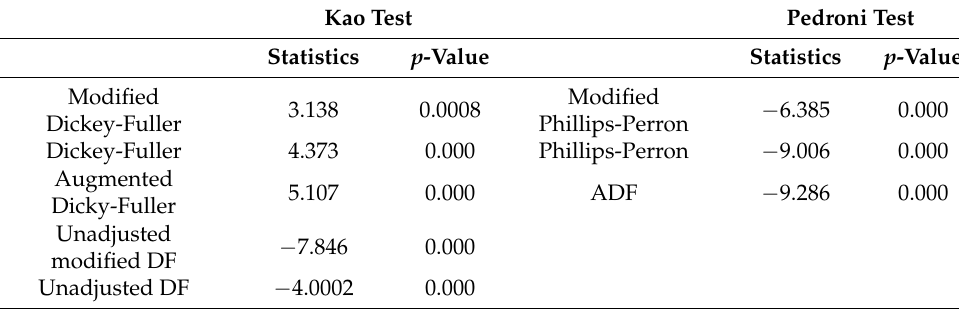
Table 5. Panel Cointegration Test